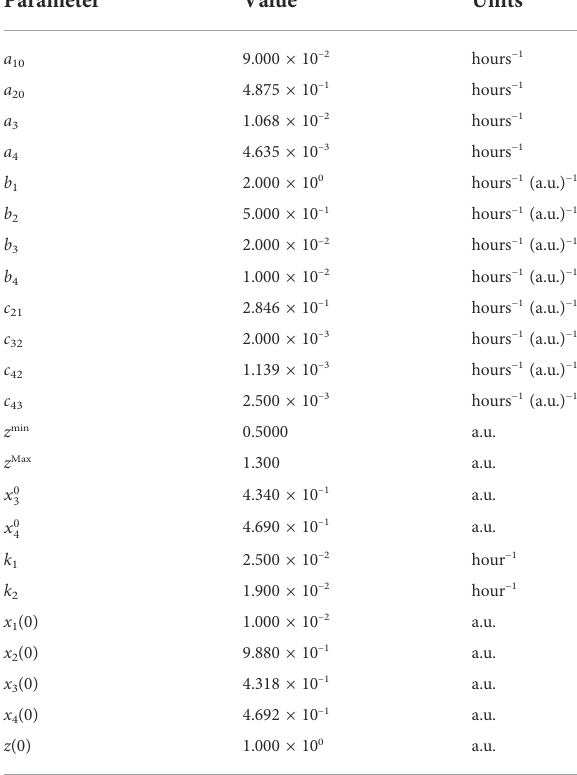
TABLE 1 Parameters and initial conditions for the biochemical model. For equation system 1: intrinsic growth rates ( a i ), self-inhibition rates ( b i ), coupling strengths between species ( c ij ). For the rate of change of the myo fi bril population (Eq. 2): Minimum value ( z min );